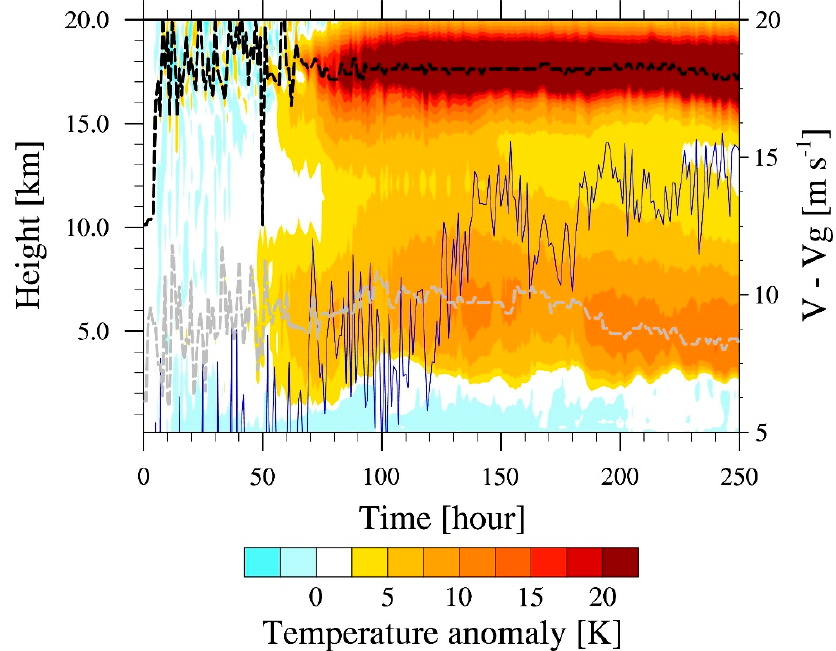
Figure 8. The temporal evolution of the vertical structure of the warm core structure in the CTL experiment. The color shading indicates the temperature anomaly as computed in Figure 7. The blue, the gray, and the black lines show the time series of the degree of supergradient wind, the height of the lower-level warm core, and the height of upper-level warm core, respectively.